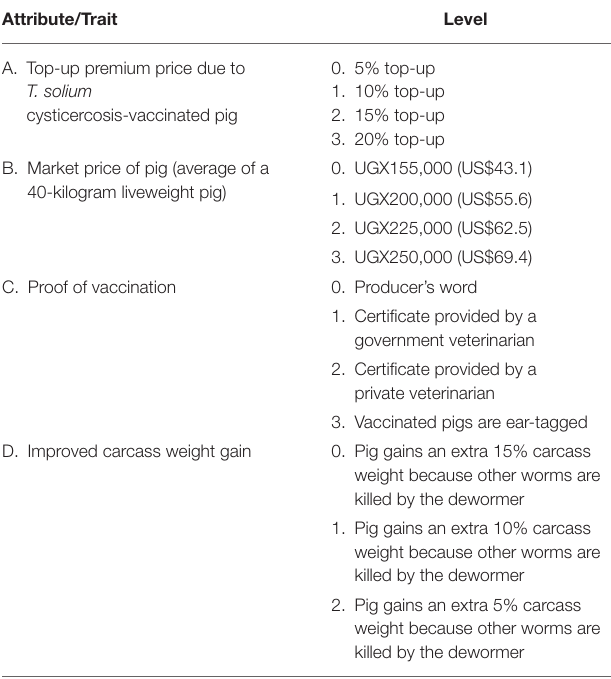
TABLE 2 | Attributes for vaccinated pigs. Attribute/Trait